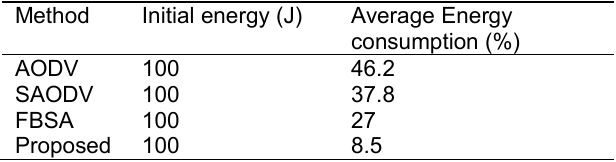
Table 6. Analysis on energy